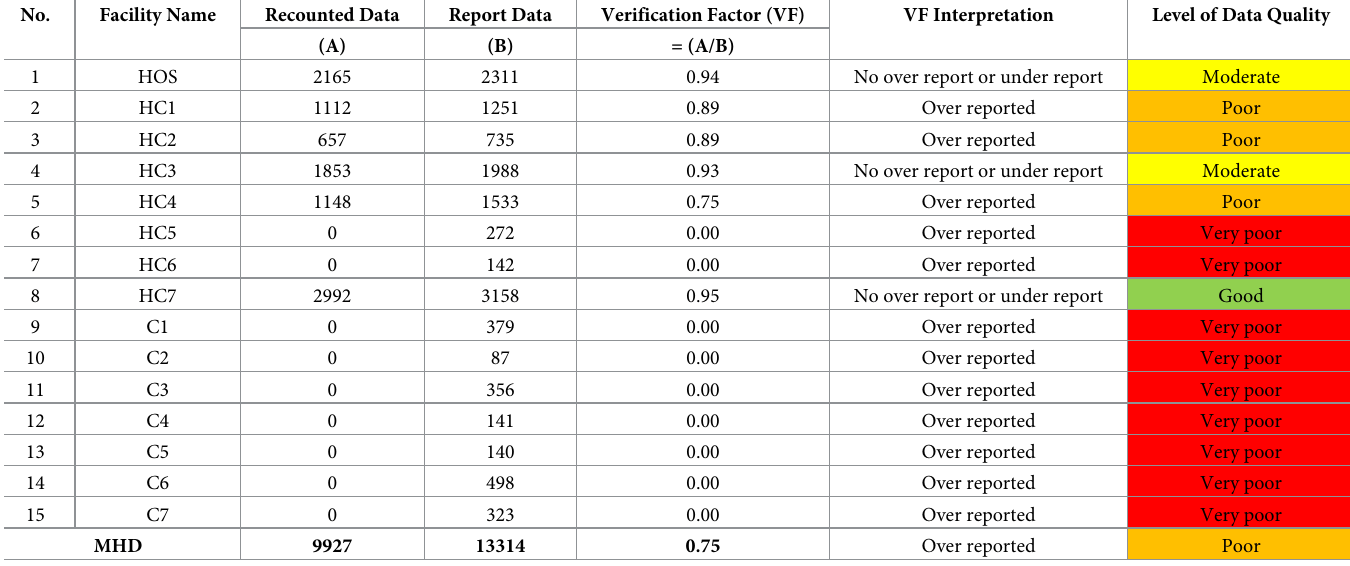
Table 7. Accuracy of reported number of OPD malaria cases treated with ACTs: Verification factor (facilities with VF = 0, do not have dispensary register where documentation of drugs issued to clients especially ACTs could be verified).